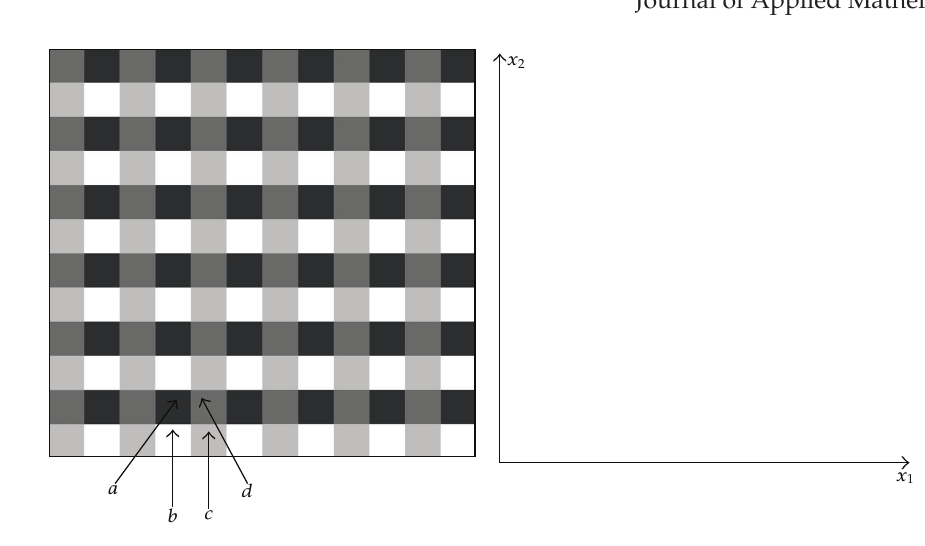
Figure 1: The four component chessboard